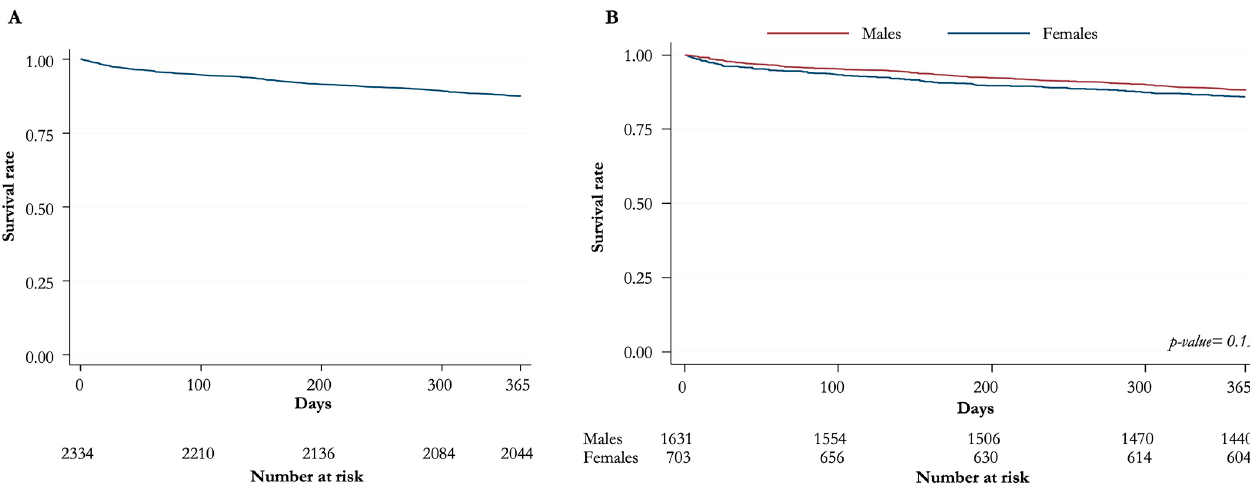
Figure 1. Kaplan–Meier curves for overall survival at 30 days. ( A ) Distribution of overall survival ( B ) Overall survival for males and females.